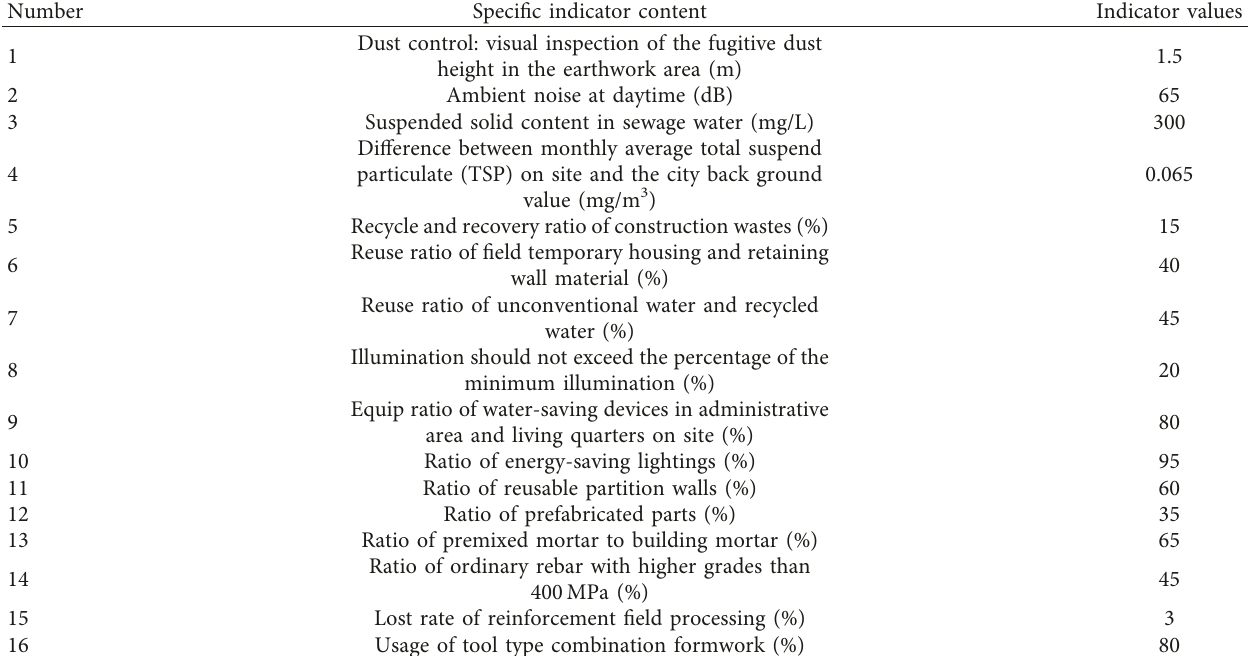
Table 8: Indicator results.